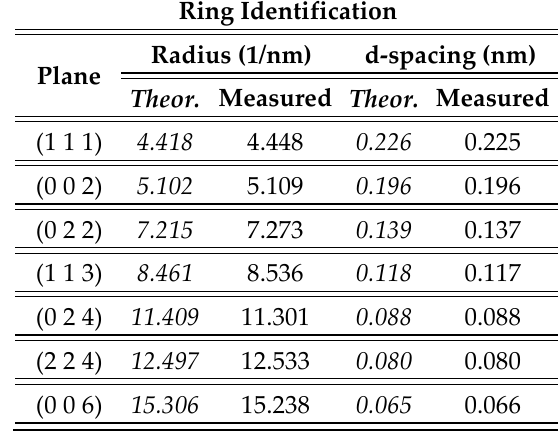
10 of 13 Figure 9. HRTEM images of Pt/Si ( a ) and PtTi/Si ( b ) as the sample start point for measuring the mean size of grain on this sample. The grain ’s mean size for the Pt/Si sample was estimated to be ~4.5 nm (Figure 9). The crystalline structure was revealed by means of electron diffraction [37 – 39]. The rings identified on the SAED pattern could be ascribed to Pt face-centered cubic structure with lattice parameter a = 0.392 nm. Figure 10b shows measured values against theoretical values. In the case of PtTi films, the crystalline structure was carried out by means of electron diffraction (Figure 10). b) Figure 10. SAED (selected area electron diffraction) investigation for Pt/Si thin films: ( a ) Indexed SAED patterns of Pt/Si film. Inset shows Miller indices for FCC (Face Centered Cubic) Pt; ( b ) Electron diffraction data.